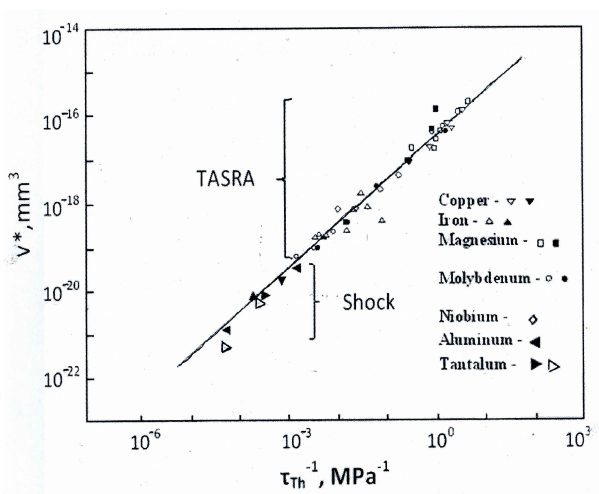
Figure 2. Thermal activation–strain rate analysis (TASRA) measurements of activation volume, v* = A*b, determinations for a variety of metals, as extended to include experimental shock test measurements [6] and incorporating (open-triangle) points for calculations based on simulated tantalum crystal shock results